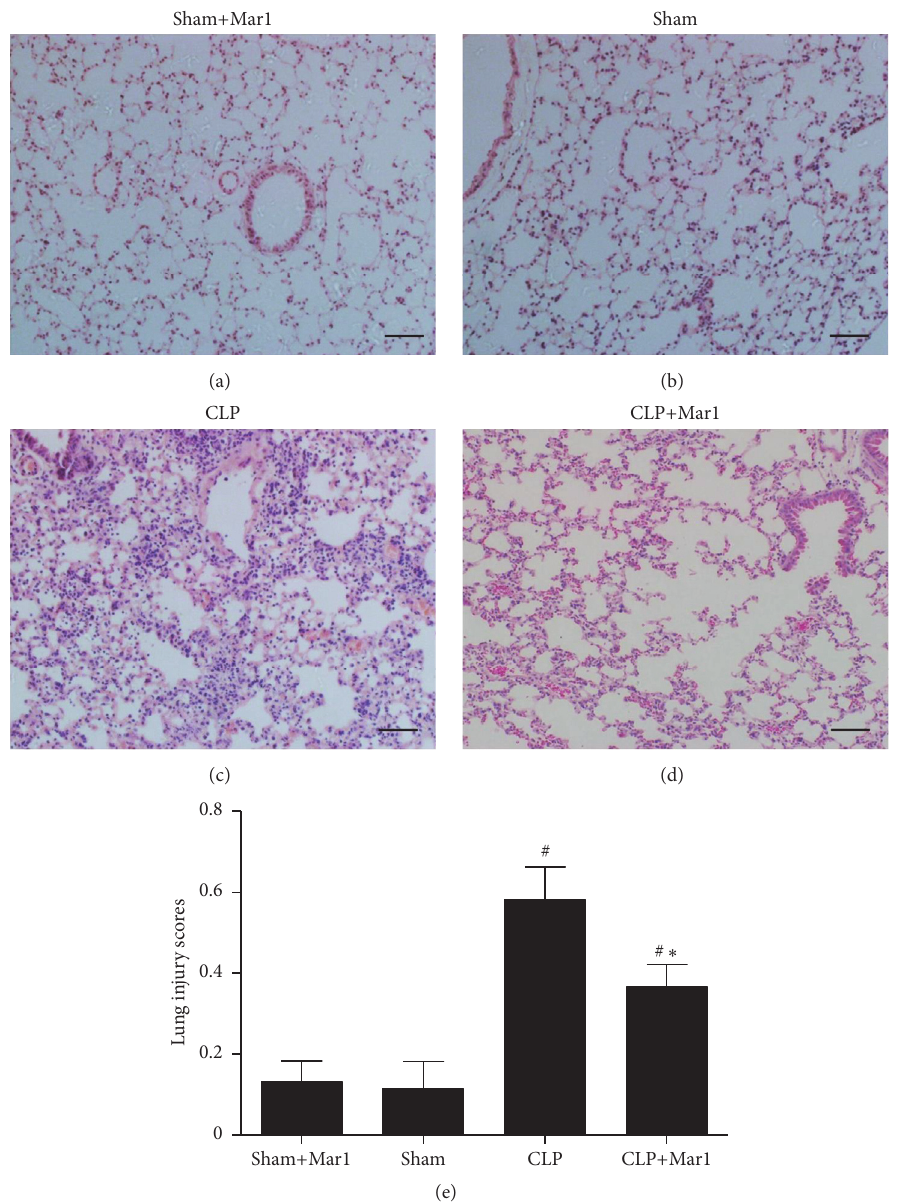
Figure 4: Improvement of lung histopathological changes by Mar1 in CLP mice. Lung tissues were obtained 24 hours after CLP. (a, b, c, and d) Representative micrographs from sham+Mar1, sham, CLP, and CLP+Mar1 group are shown. (e) Lung injury score in each group. Data are expressed as means ± SEM. Black bars represent 100 𝜇 m. 𝑛 = 5 . # 𝑃 < 0.05 versus the sham group. ∗ 𝑃 < 0.05 versus the CLP